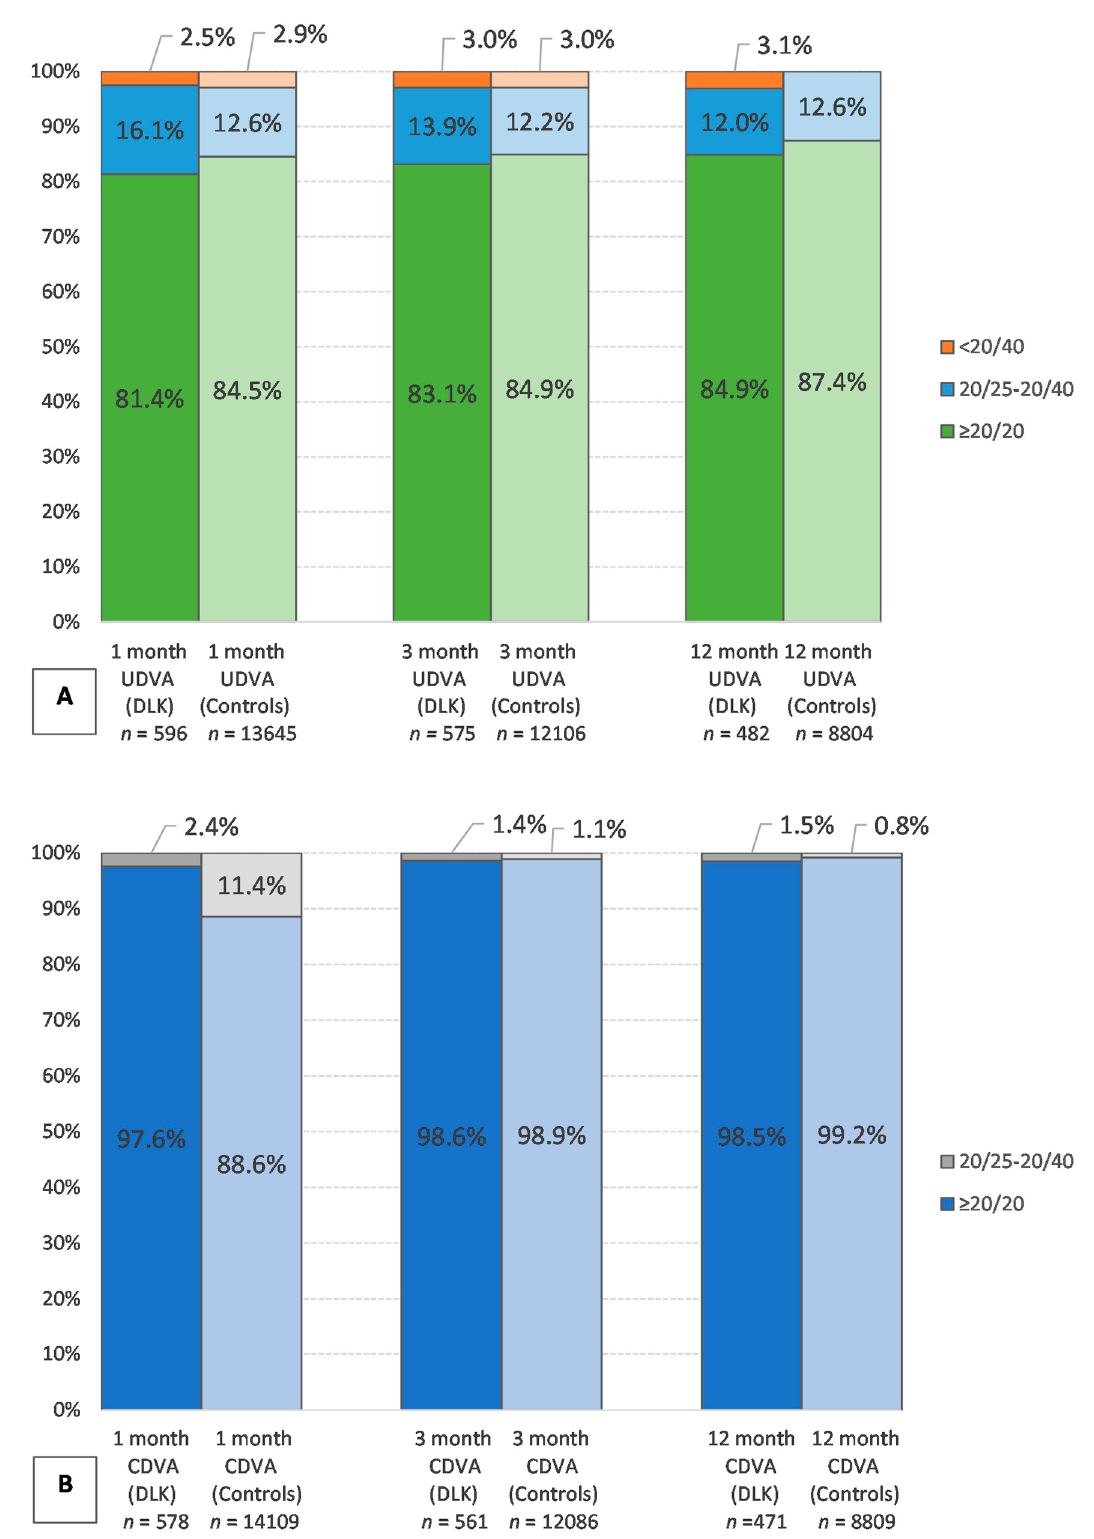
Figure 2. Visual outcomes of controls compared with DLK cases at 1, 3, and 12 months. ( A ) Comparison of UDVA over 1–12 months postoperatively. ( B ) Comparison of CDVA over 1–12 months postoperatively. DLK—diffuse lamellar keratitis; UDVA—uncorrected distance visual acuity; CDVA—corrected distance visual acuity.